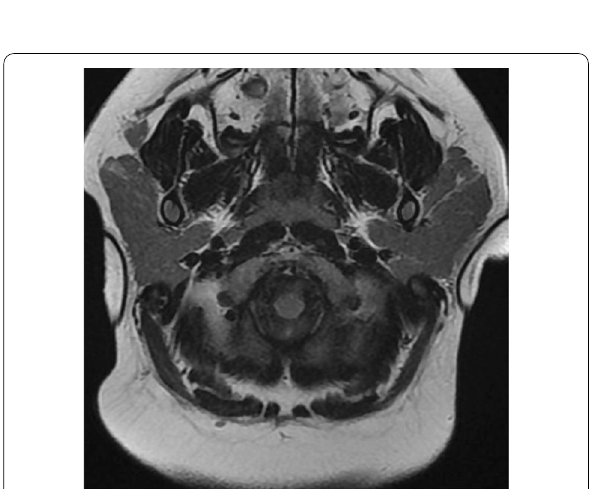
Fig. 20 Sialadenosis in an obese teenager. Diffuse enlargement of both parotid glands whose signal is normal and abundant subcutaneous fat, on axial T 2 ‑weighted